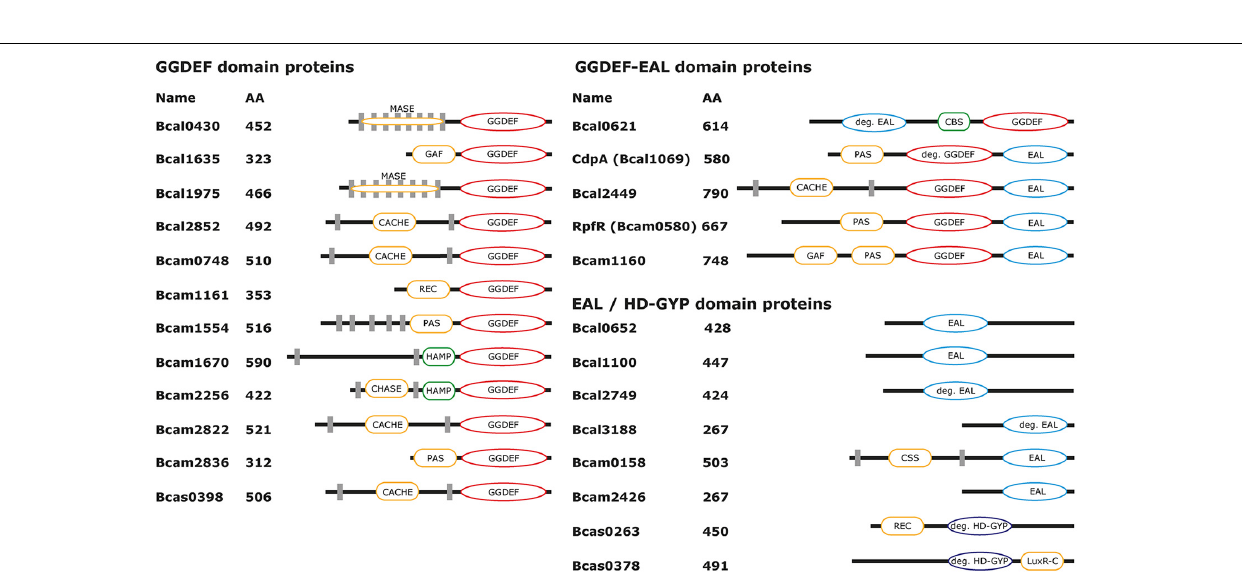
Frontiers in Microbiology |